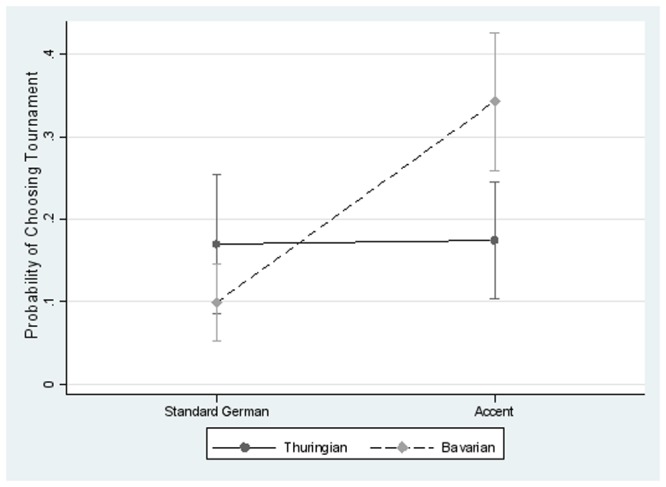
Payoff matrix for tasks 2–5.Color indicates potential gains (green) and losses (orange) compared to piece rate. Piece rate: m = Ʃca * € 0.50; revenue sharing: m = (Ʃca + Ʃcb) / 2 * € 0.50; tournament: m = Ʃca * € 1.40 if Ʃca > Ʃcb otherwise m = Ʃca * € 0.20, with m = payoff; ca = successful completion of task by participant A; cb = successful completion of task by speaker B.